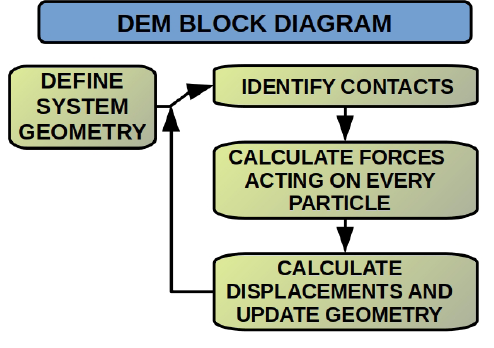
Figure 1: The scheme of DEM simulation (after O’Sullivan 2011).